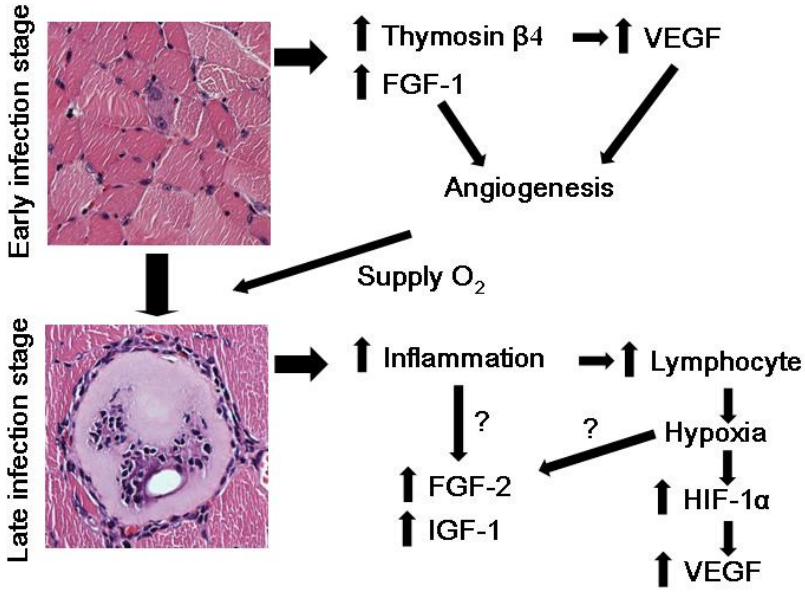
Figure 1. Proposed mechanism of thymosin β4-mediated vascular endothelial cell growth factor (VEGF) induction in T. spiralis -infected nurse cells. Induction of thymosin β4 in early infection stimulates expression of VEGF to induce angiogenesis in early stage nurse cells. Induction of fibroblast growth factor (FGF)-1 also stimulates angiogenesis and the induction of angiogenesis can supply oxygen to nurse cells without having to go through a hypoxic state. At late stages of infection, inflammation around infected nurse cells occurs and lymphocytes accumulate around damaged nurse cells. The hypoxic conditions due to the accumulation of lymphocytes protect hypoxia-inducible factor (HIF)-1α from hydroxylation and degradation resulting in the transcriptional activation of VEGF expression. Other factors including FGF-2 and insulin-like growth factor (IGF)-1 may also be involved in inflammation or the hypoxic stimulation of gene